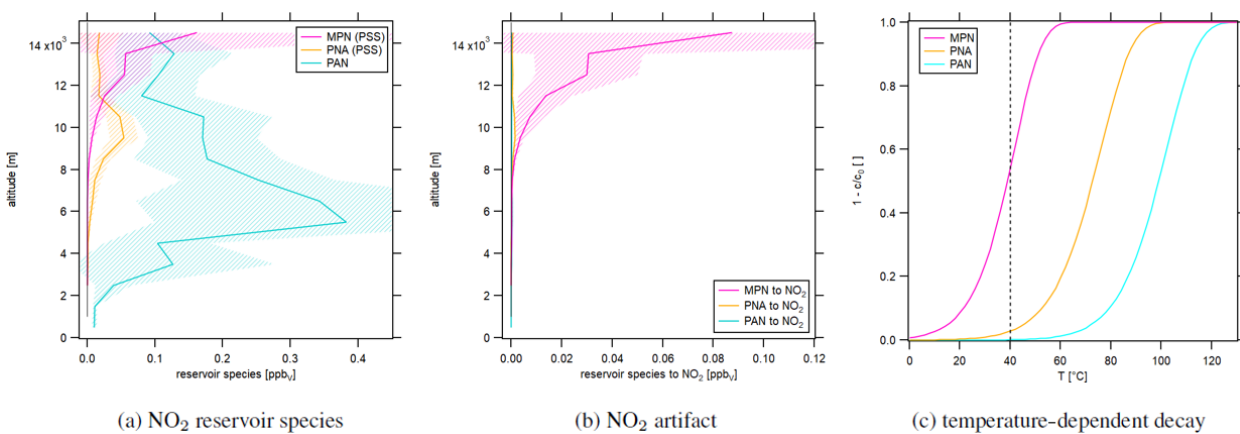
Figure 3. Vertical profiles of (a) NO 2 reservoir species MPN, PNA (from PSS calculations) and PAN (measured during CAFE Africa) as well as (b) NO 2 artifacts in the blue light converter from reservoir species according to first-order decay. The shaded plot areas present the 1 σ standard deviation resulting from averaging the concentrations at each considered altitude range. (c) Temperature-dependent decay of the NO 2 reservoir species in the type 1 blue light